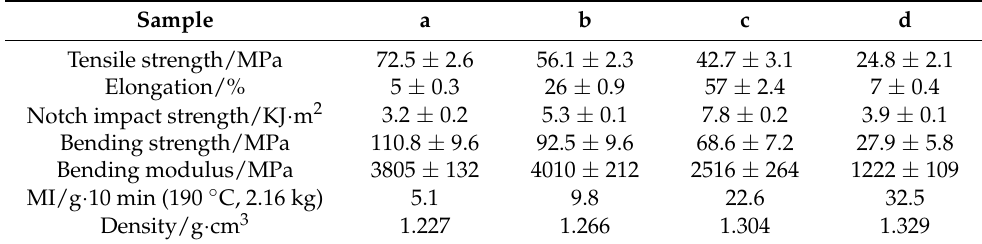
Table 3. Mechanical properties of TPS/PLA blend.